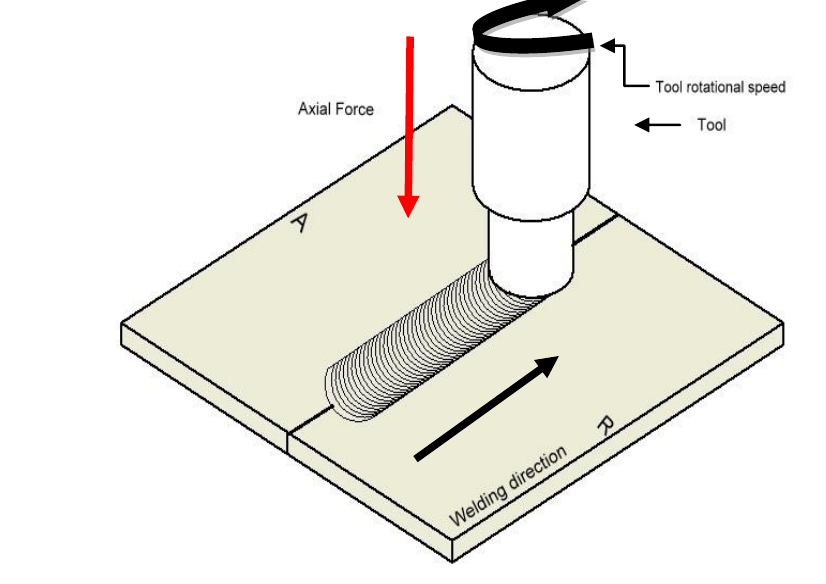
Fig. 1 Schematic Diagram of Friction Stir Welding of Aluminum